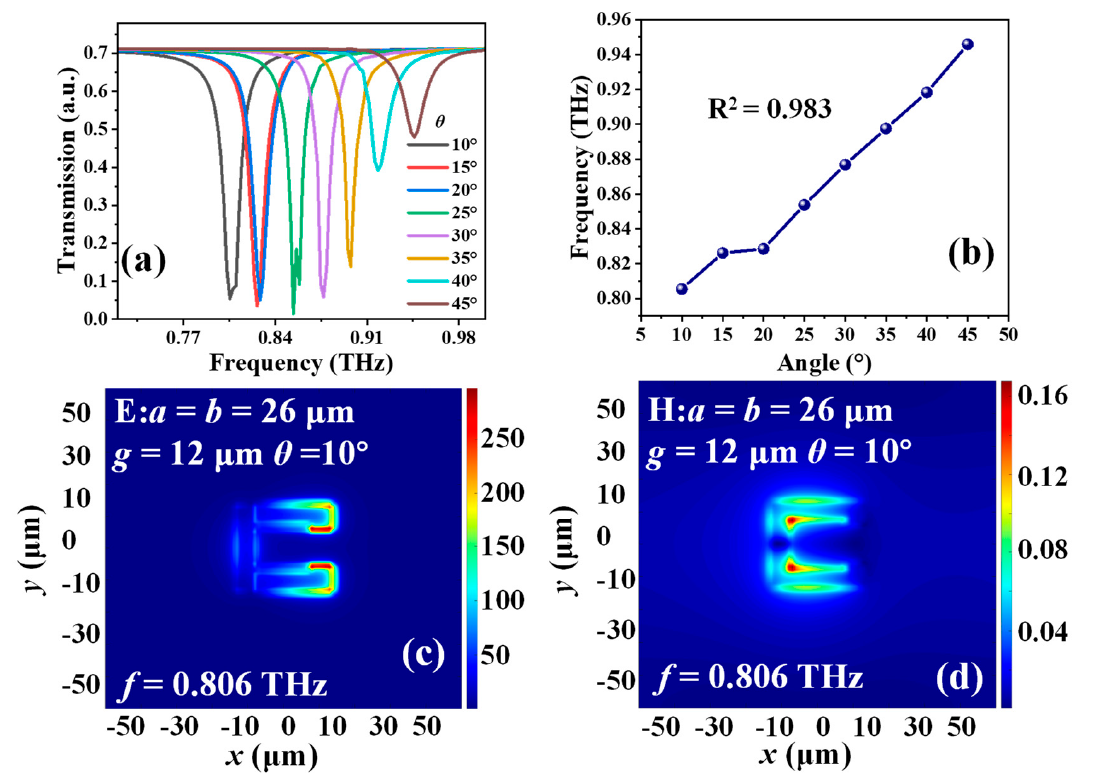
Figure 6. ( a ) Transmission spectra of MTM with different θ values. ( b ) Relationship of θ values and resonances. ( c ) E– and ( d ) H–field distributions of MTM with a = b = 26 μ m, and θ = 10° in TE mode.